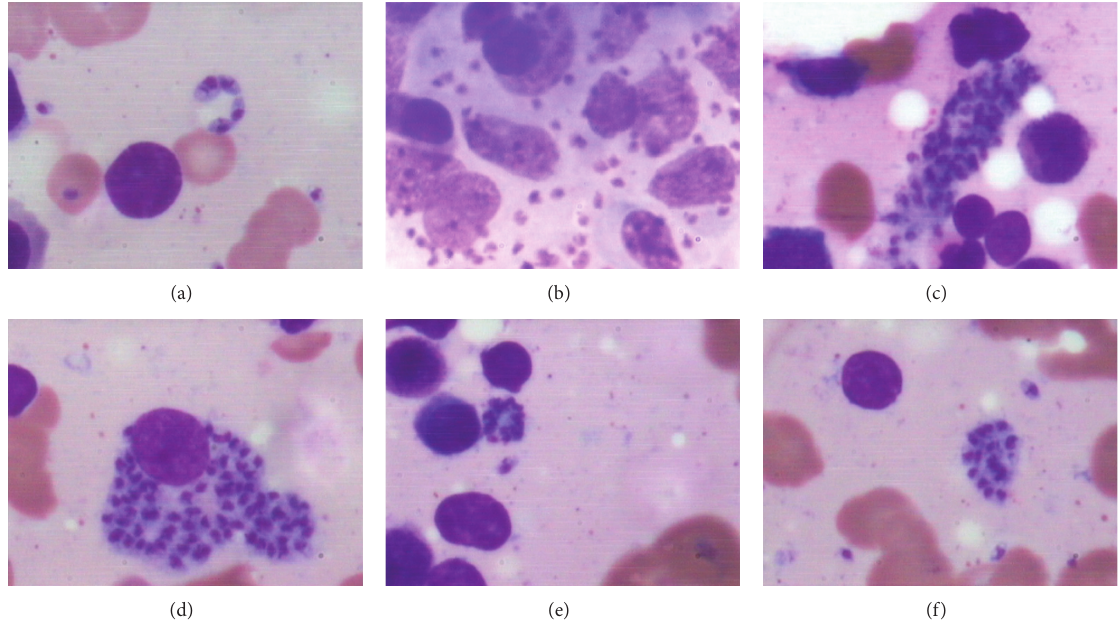
Figure 3: Bone marrow aspirate showing various forms of aggregates of LD bodies, (a) ring shaped aggregate of LD bodies, (b) intracellular and extracellular LD bodies, (c) strap shaped aggregate of LD bodies in cytoplasmic fragment, (d) intracellular aggregates of LD bodies, (e) floret arrangement of LD bodies and (f) LD bodies aggregate in cytoplasmic fragment (Jenner Giemsa; ×